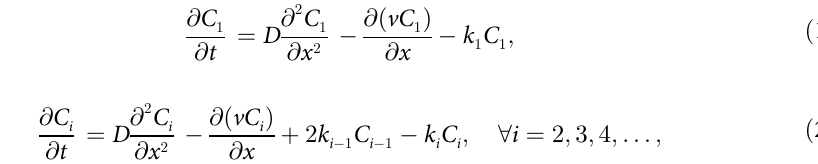
Fig 1. Schematic illustration of two different lineage trees. (a) Lineage tree for a cell proliferation process where each cell gives rise to two daughter cells in the following generation. (b) Lineage tree for a cell differentiation process where each cell undergoes a differentiation process to produce a single cell of a different